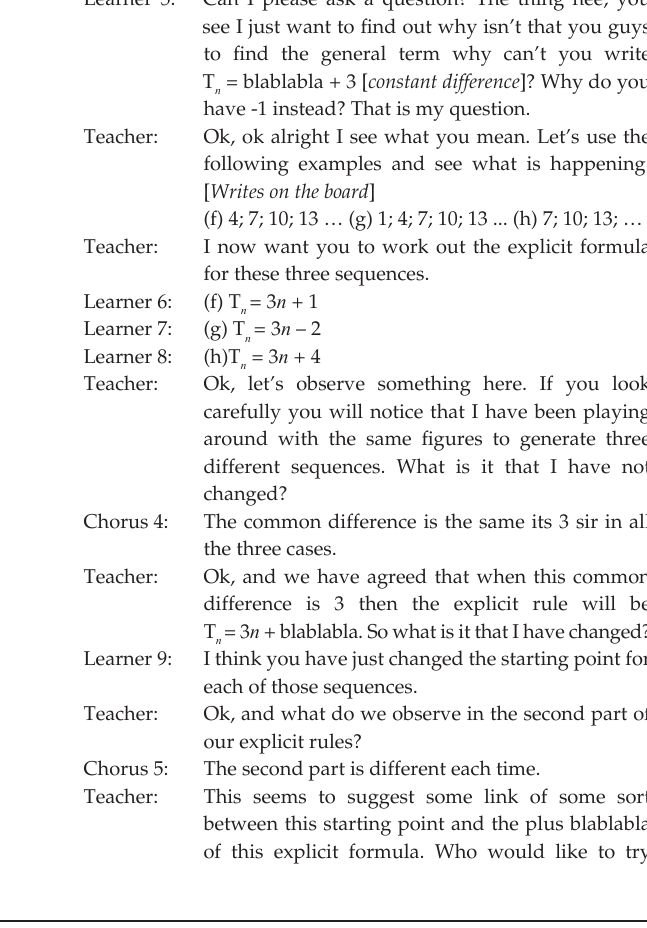
TABLE 1: Summary of discernment unit 1.